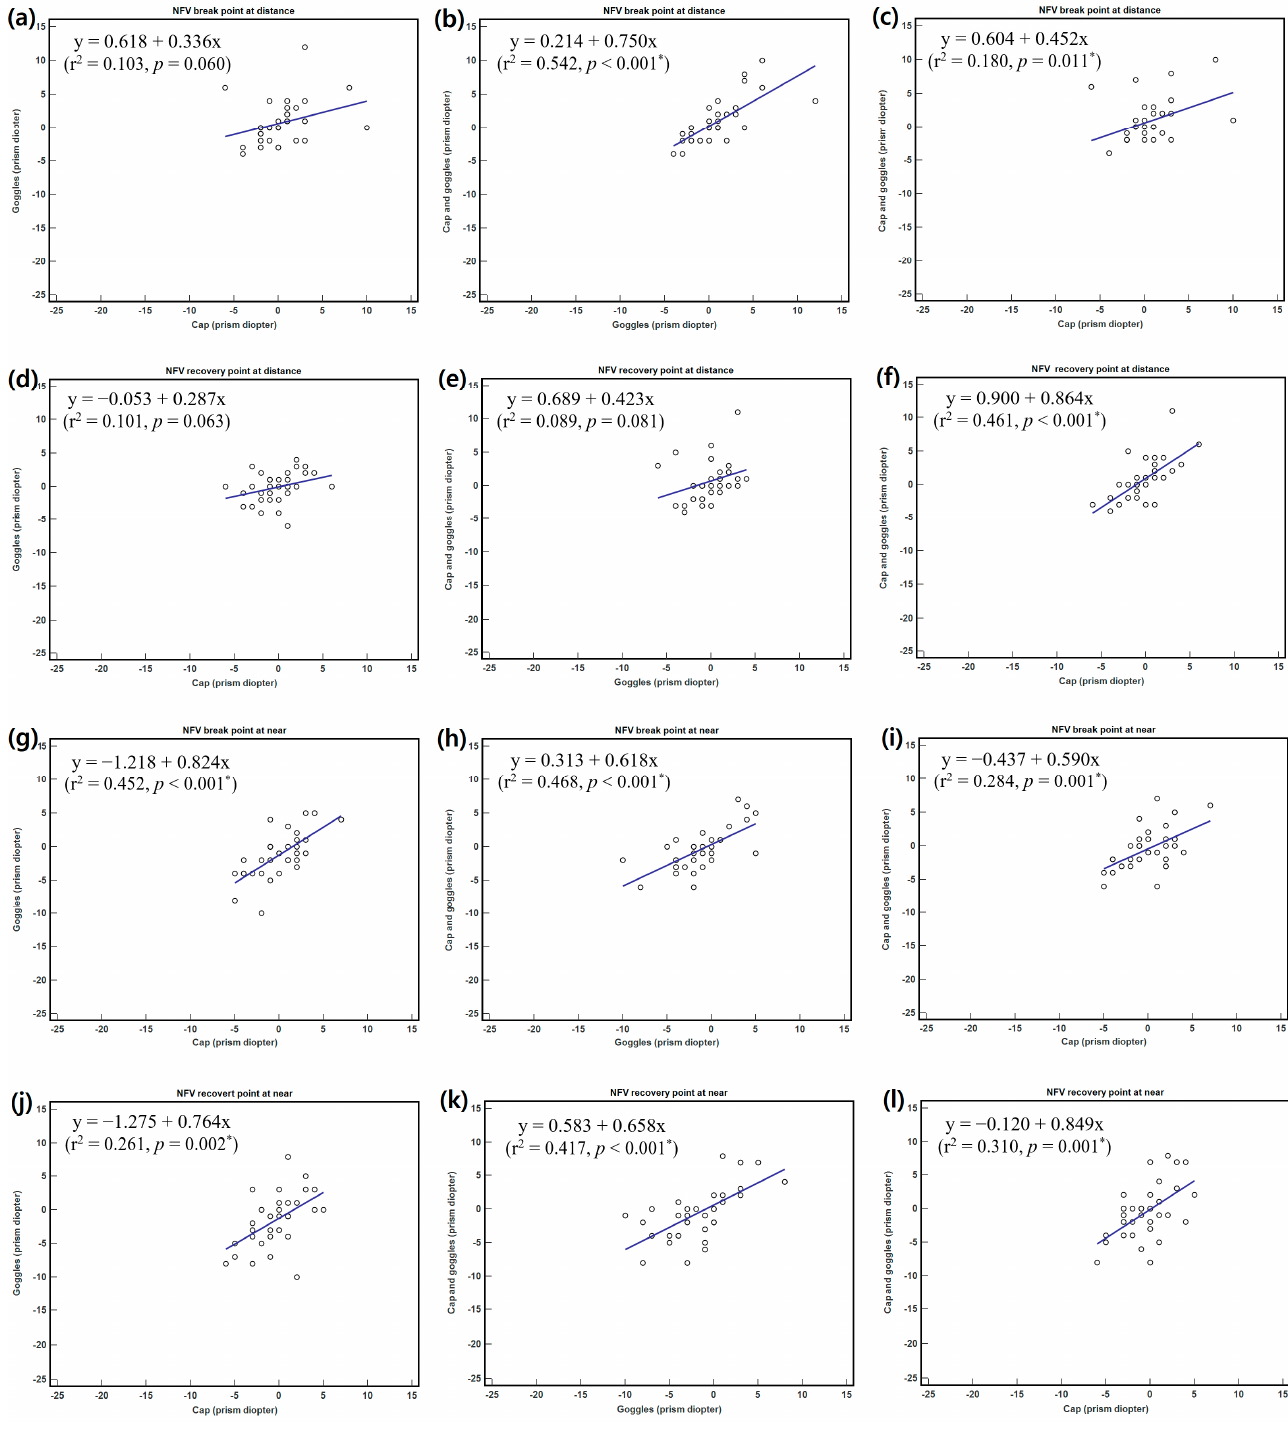
Figure 2. Regression analyses between a swimming cap, goggles, and both a cap and goggles for changes in break and recovery points of negative fusional vergence at distance and near. ( a ) Cap vs. goggles, ( b ) goggles vs. cap and goggles, and ( c ) cap vs. cap and goggles for the NFV break point at distance; ( d ) cap vs. goggles, ( e ) goggles vs. cap and goggles, and ( f ) cap vs. cap and goggles for the NFV recovery point at distance; ( g ) cap vs. goggles, ( h ) goggles vs. cap and goggles, and ( i ) cap vs. cap and goggles for the NFV break point at near; ( j ) cap vs. goggles, ( k ) goggles vs. cap and goggles, and ( l ) cap vs. cap and goggles for the NFV recovery point at near. R-squared (r 2 ) is the coefficient of determination. * p < 0.05 indicates a statistically significant finding.